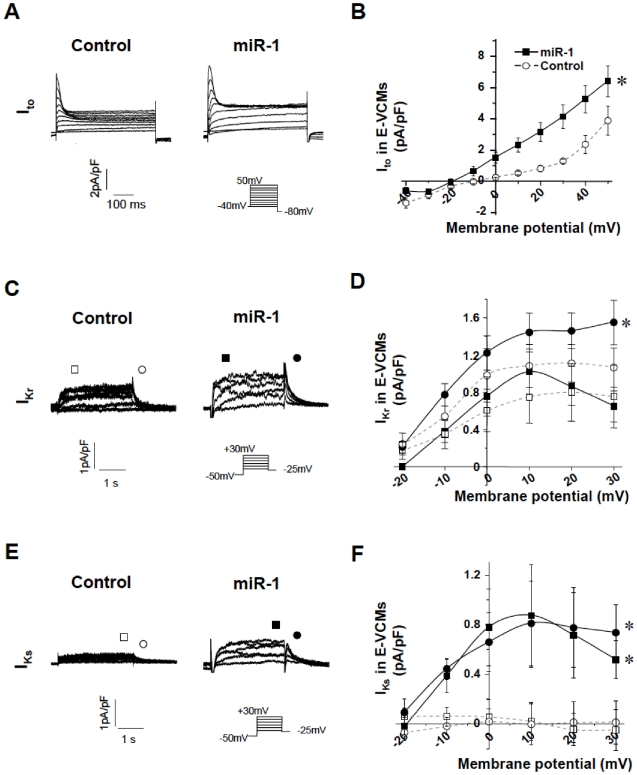
Currents and Current-Voltage Relationships in Control and miR-1 Transduced hE-VCMs.A, C and E) Representative tracings of Ito, IKr and IKs recorded from WT, LV-miR-1-transduced E-VCMs as labeled. Currents were elicited by the electrophysiological protocol given in the inset. Currents shown were 4-Aminopyridine-, Chromanol 293B- and E4031–sensitive, respectively. B, D and F) The corresponding current-voltage (I–V) relationships. *, p<0.05.